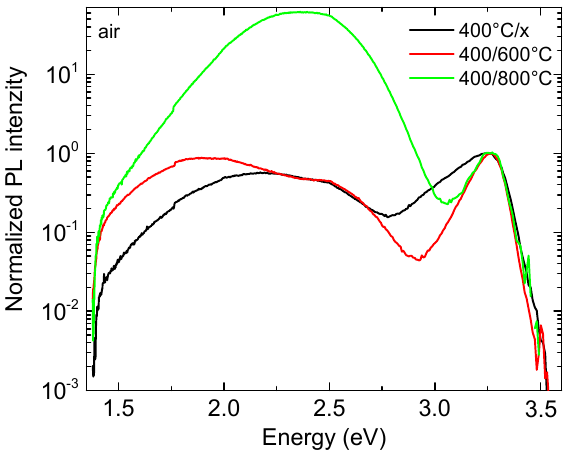
Figure 7. Room temperature photoluminescence spectra of the seed layer preheated and annealed in the air at different temperatures. Black line 400 °C; red line 400 °C/600 °C; green line 400 °C/800 °C.